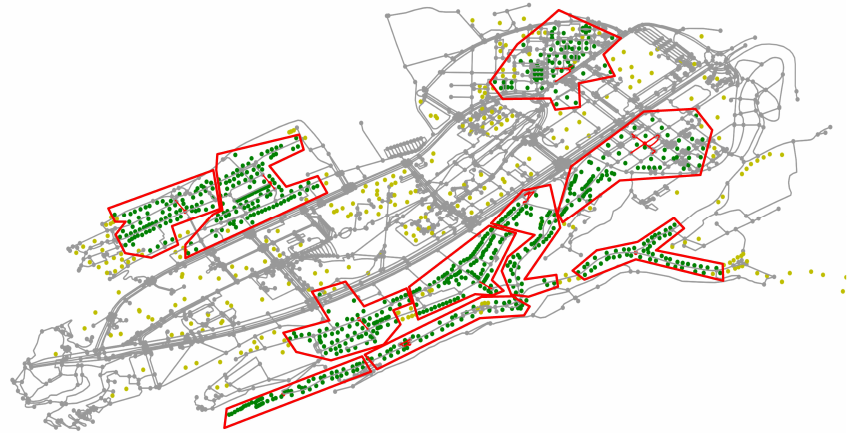
Figure 8. A map showing a solution from NSGA-II that yields the highest user coverage and the highest maximum walking distance. Covered buildings are depicted as nodes inside polygons.